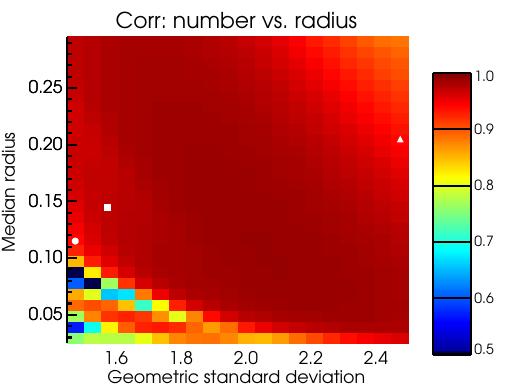
Figure 5. The a posteriori correlation between retrieved total num- ber concentration and median radius is here shown as a 2-D slice through the five-variable state space. The complex refractive index is held fixed at 1.470–0.00325i, the total number concentration is held fixed at 1001cm − 3 , and the dependence on median radius and geometric standard deviation is depicted. Symbols show the values of median radius and geometric standard deviation for cases 1 (cir- cle), 2 (square), and 3 (triangle), which also have the same complex refractive index as the illustrated slice.